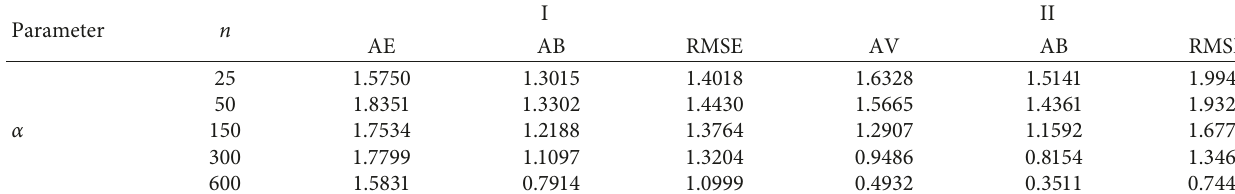
Table 4: Simulation results of EFL regression